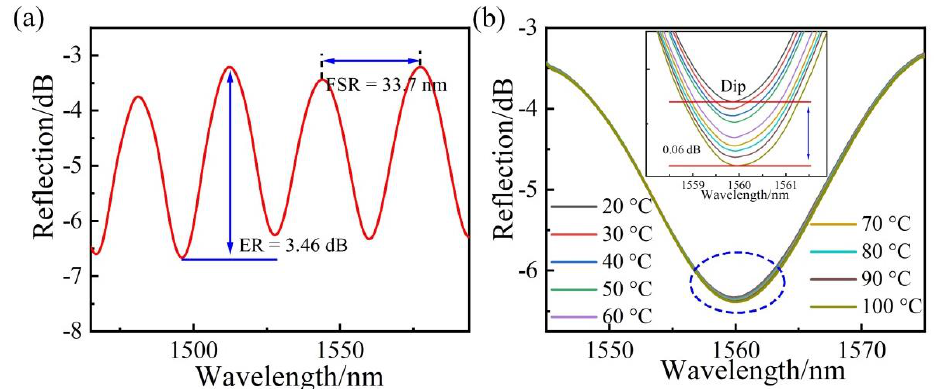
Figure 5. ( a ) Reflection spectra of the MLG-based heat resonator. ( b ) The changes in the reflection spectra at different temperatures and the inset shows the partial enlarged view of the spectrum change.